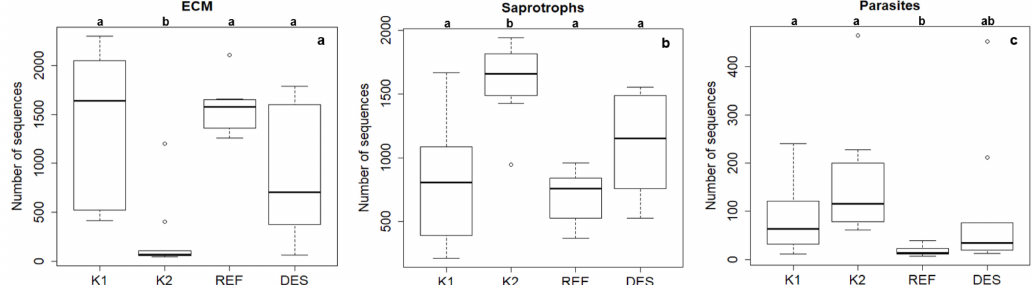
Figure 2. Differences in fungal trophic group abundance based on the number of sequences: ( a ) ECM fungi, ( b ) saprotrophic fungi, and ( c ) parasitic fungi detected in forest that is attacked by bark beetle (K1), destroyed by bark beetle (K2), with removed trees (DES), and mature (REF). The diagrams represent median, quartiles, and range (1.5 * IQR) from 10 microsites.